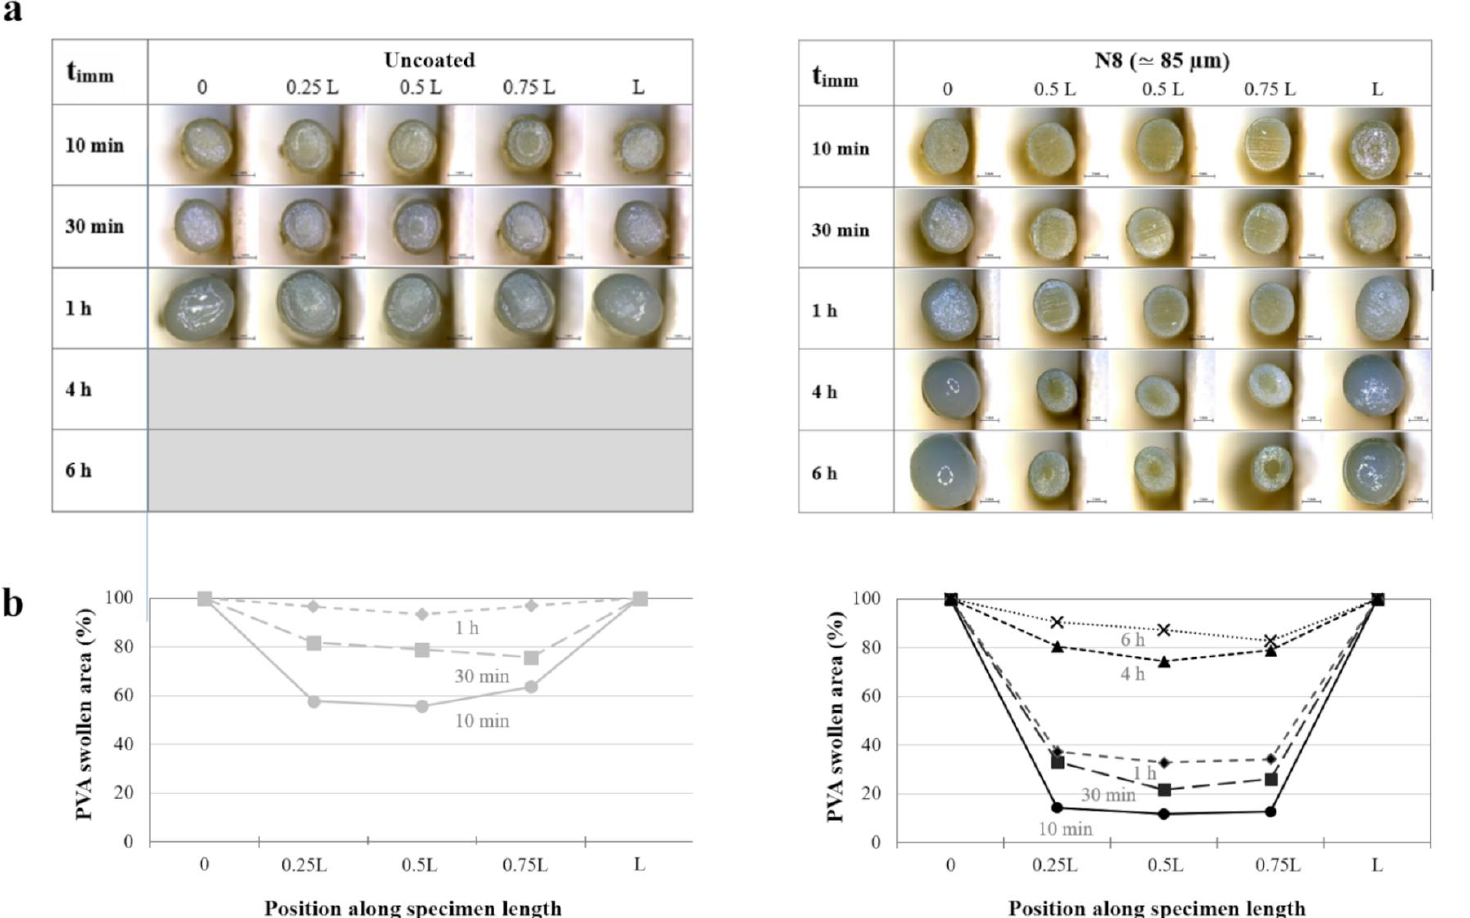
Figure 8. ( a ) Photographs of cross-sections of uncoated and coated N8 prototypes at different positions along their length after increasing immersion times and ( b ) profiles of the corresponding swollen area.